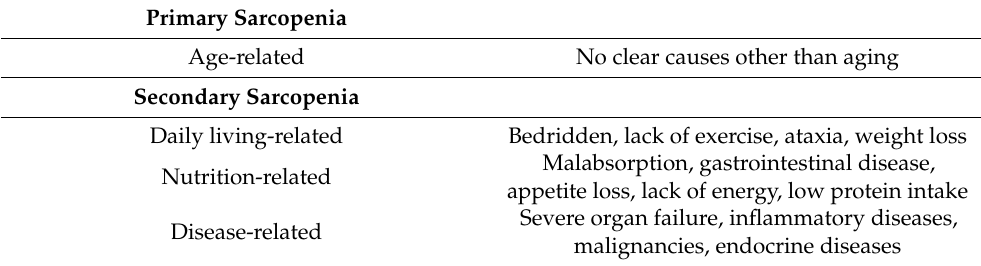
Table 1. Classification of sarcopenia by causes.